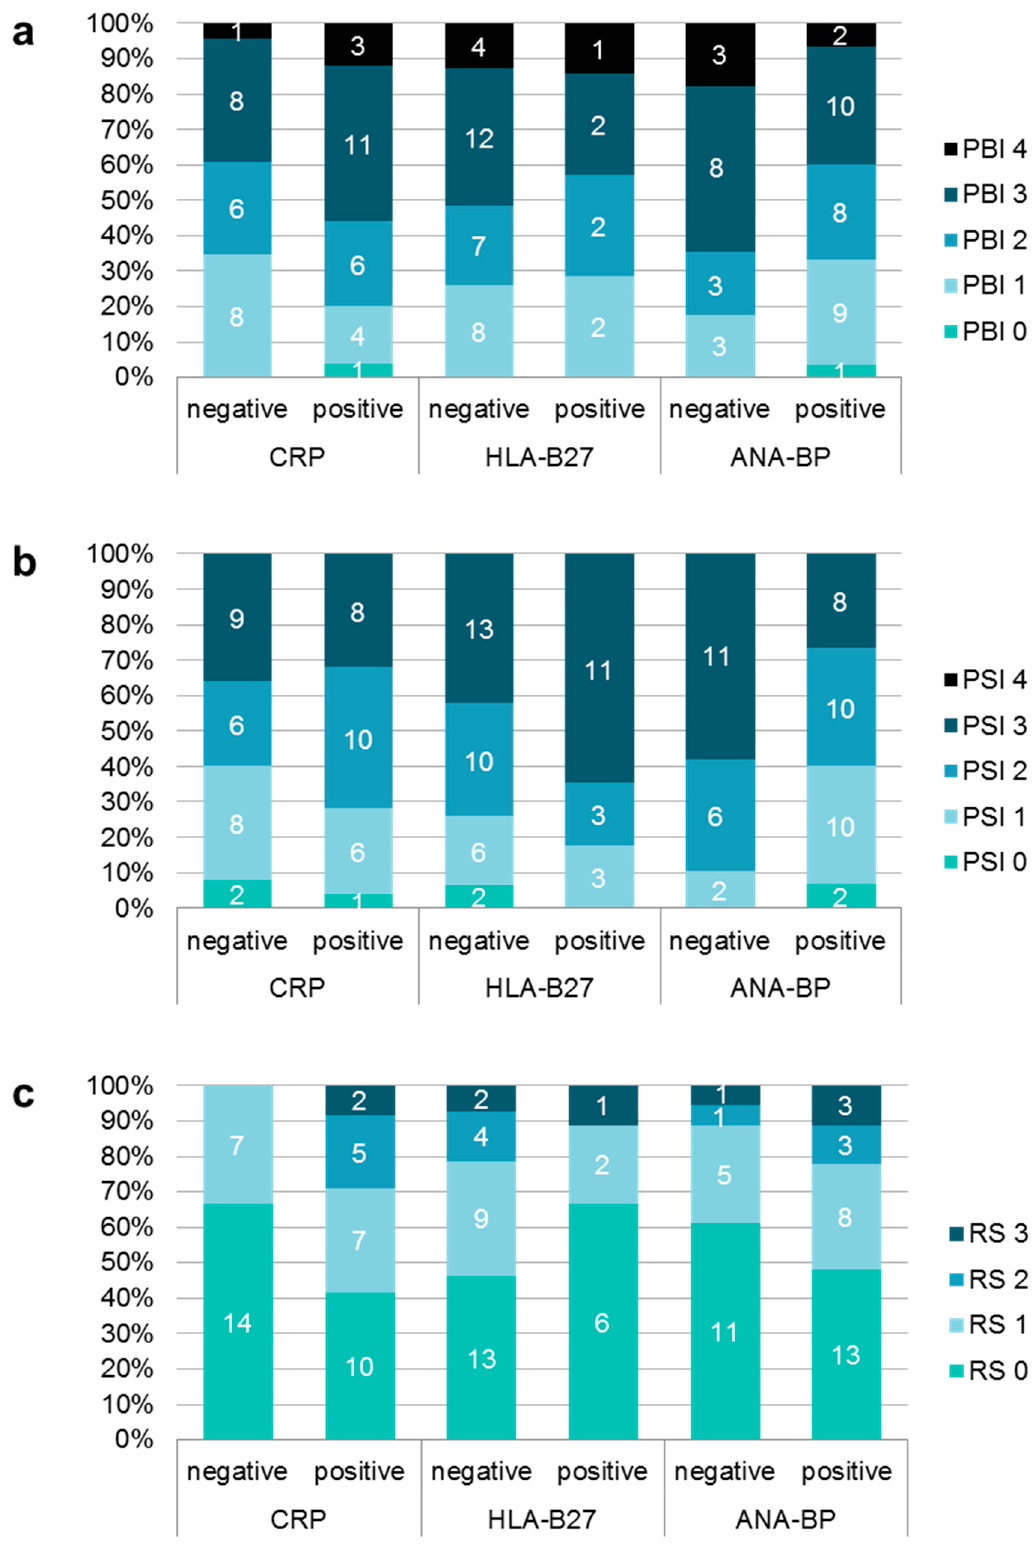
Figure 1. Distribution of di ff erent scores of papilla bleeding index (PBI); ( a ), periodontal screening index (PSI); ( b ) and radiographic score (RS); ( c ) depending on di ff erent blood values.